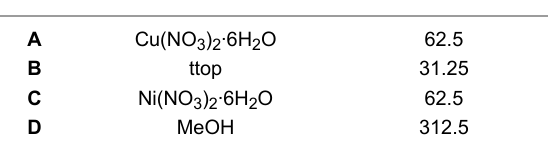
Table 2: An overview of the solutions and flow rates used for the reac- tion of ttop with Cu(NO 3 ) 2 ·6H 2 O and Ni(NO 3 ) 2 ·6H 2 O